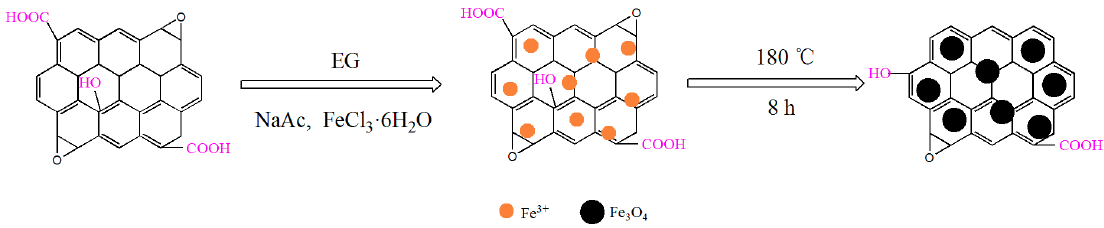
Figure 1. Synthesis process of the Fe 3 O 4 /rGO composites.